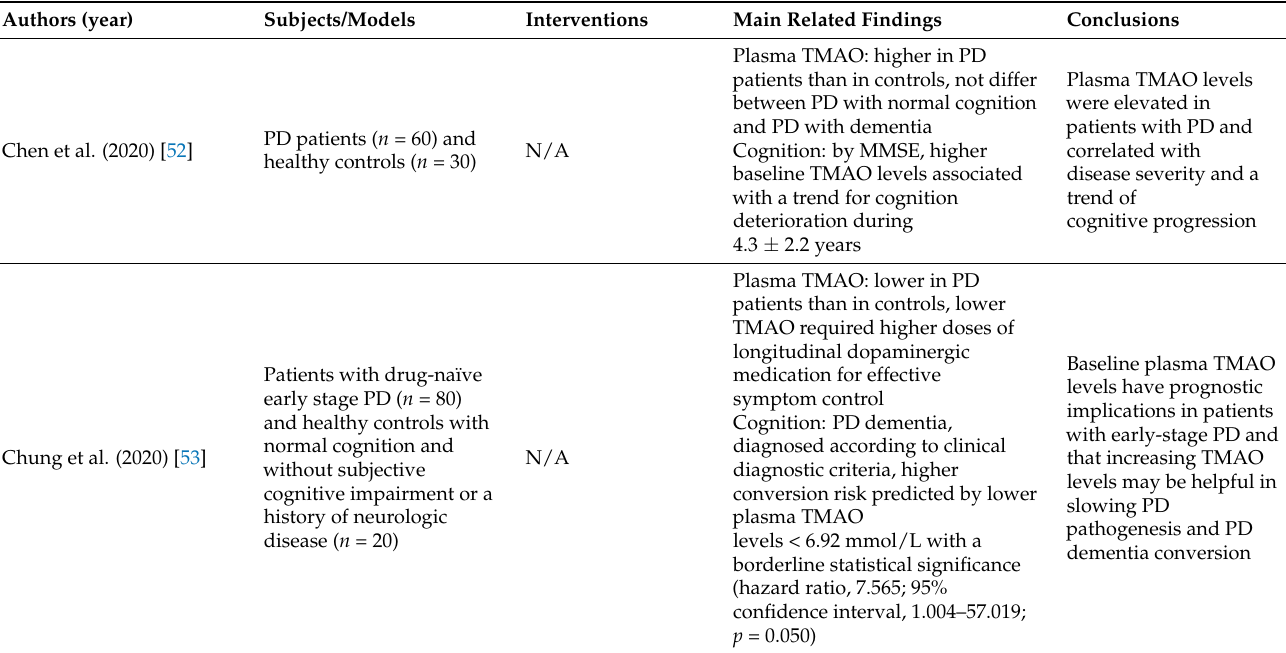
Table 4. Main studies involving TMAO and Parkinson’s